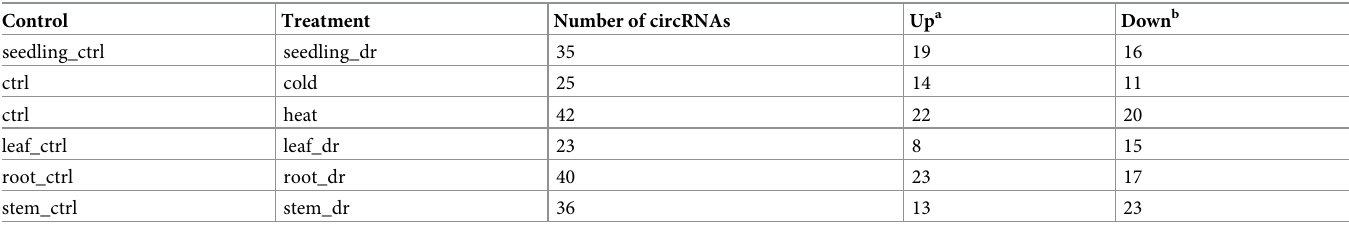
Table 2. Differential expression of circRNAs between control and